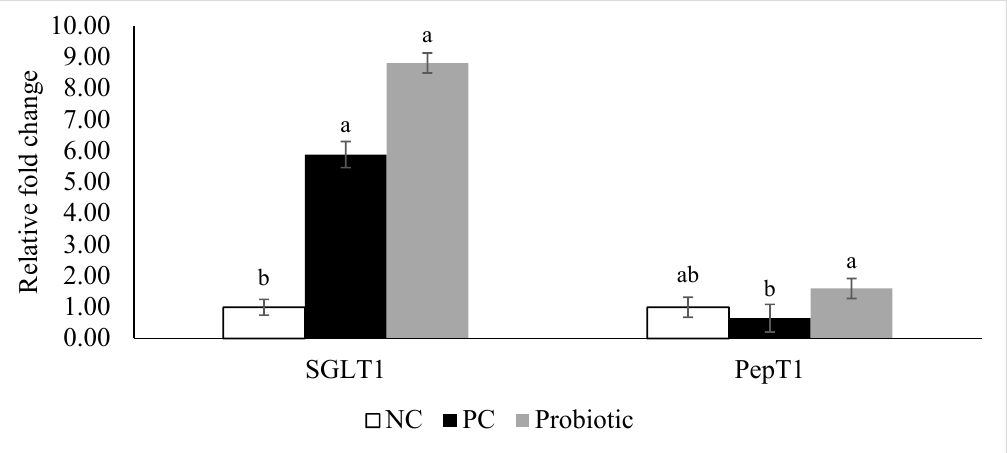
Figure 2. Relative gene expression of sodium-glucose co-transporter 1 (SGLT1) and peptide transporter 1 (PepT1) in the jejunum of broiler chickens on d 8. Birds reared under a naturally occurring necrotic enteritis challenge model. Treatments include: negative control (NC): birds received a corn-soybean meal basal diet; positive control (PC): NC + virginiamycin (Stafac ® 20) at the level of 0.45 kg/ton from d 0–42; Probiotic: NC + PrimaLac at the level of 1.36 kg/ton in starter and grower 1 diets; 0.91 kg/ton in grower 2 and finisher diets. Values are represented as a n -fold difference relative to the calibrator (negative control, NC). Results are given as means ( n = 12) for each treatment. Error bars indicate standard errors. For each gene, bars with different letters are significantly different ( P < 0.05).